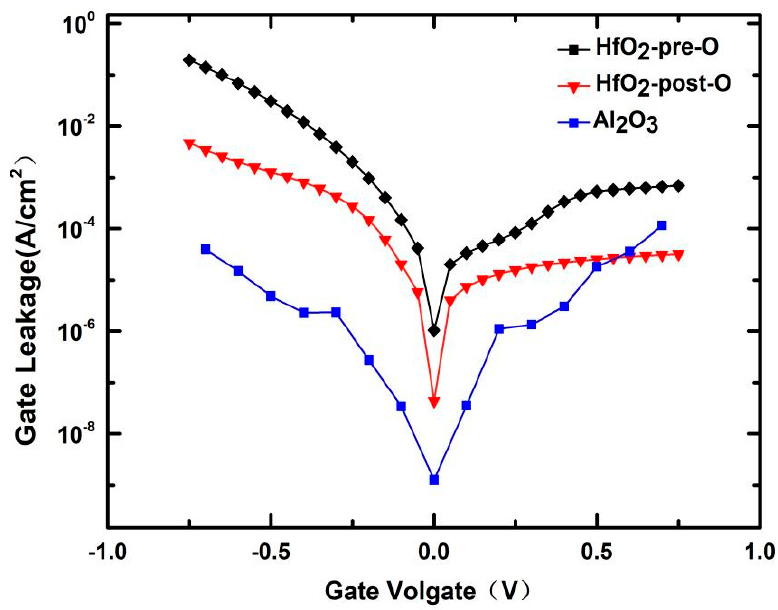
Figure 3. Gate leakage of Al 2 O 3 sample, HfO 2 ‐ pre ‐ O sample and HfO 2 ‐ post ‐ O sample.